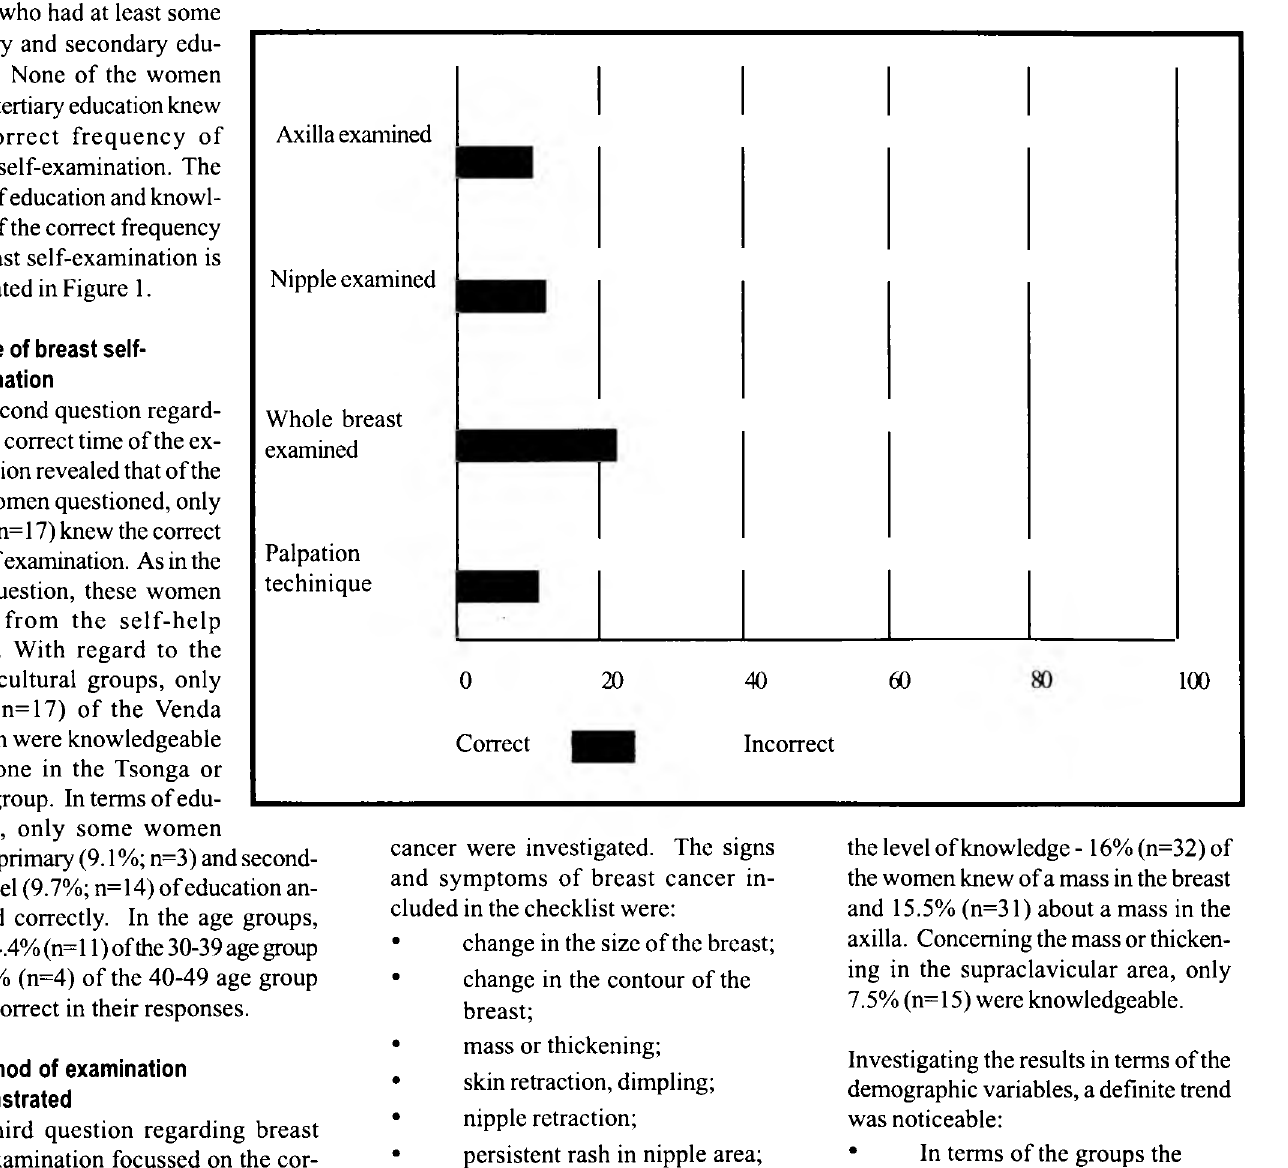
FIGURE 2: Method of examination